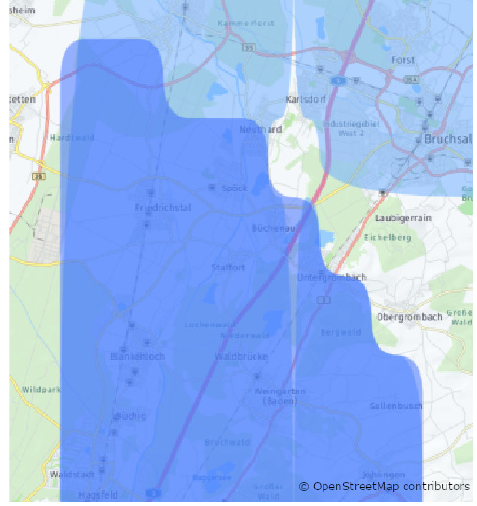
Figure 10. Smoothing problem when over-posing cloud